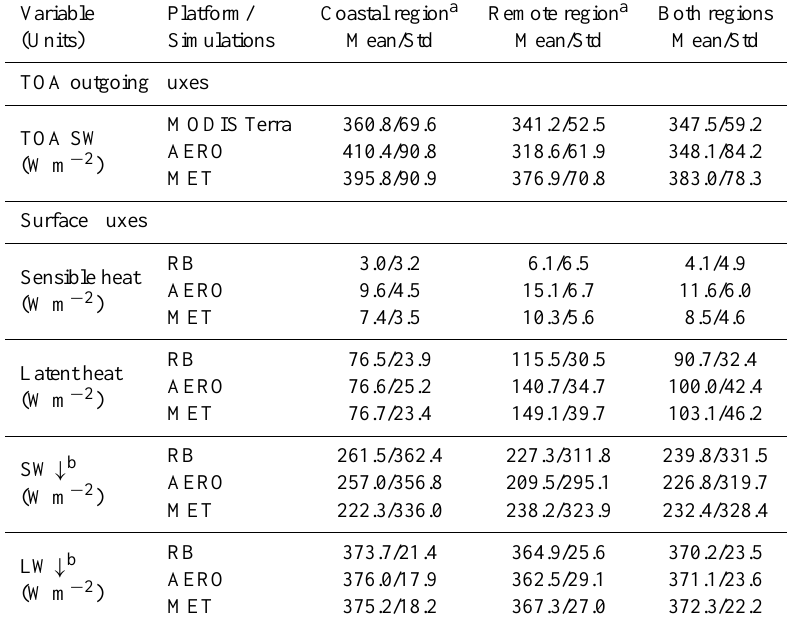
Table 6. Observed and simulated top-of-atmosphere (TOA) outgoing shortwave radiation and surface fluxes. Variable